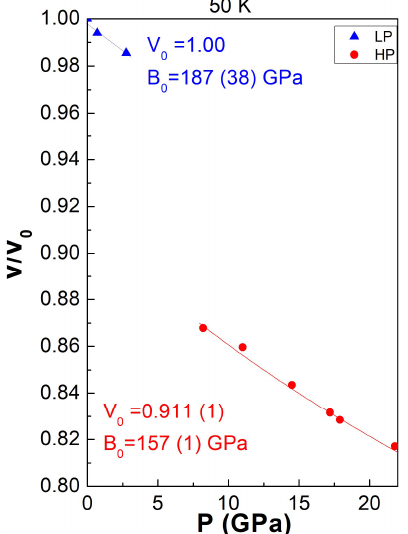
Figure 7. Pressure dependence of the LuFe 2 O 4 low pressure T1 and monoclinic M2 high pressure forms at 50 K.